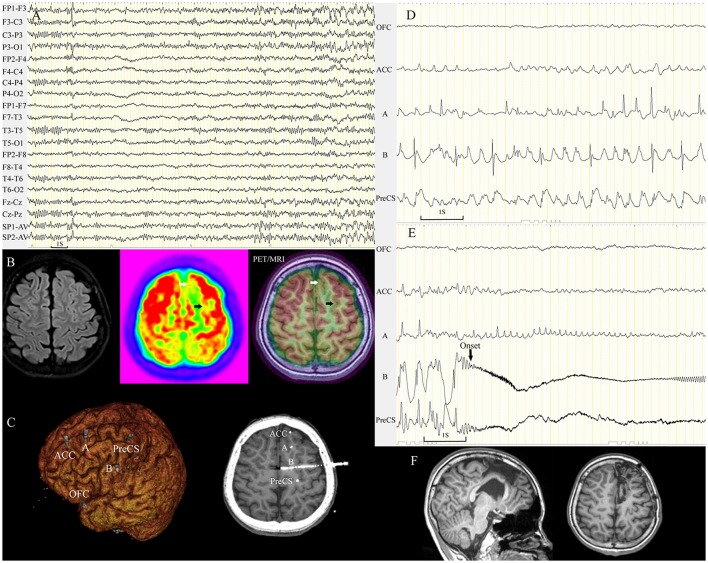
Subtle hypometabolic change tended to be overlooked by conventional visual analysis. A 12-year-old boy (patient 32) with nocturnal seizures manifesting as aura (fear/fluster), tachycardia, fearful expression, dystonic posturing of the right limbs, and hypermotor activity. Ictal scalp EEG demonstrated sharp waves in the left frontal lobe (A). Visual analysis identified focal PET hypometabolism in the left mesial frontal region (white arrow). PET/MRI detected a very subtle hypometabolic change (black arrow) in the ipsilateral superior frontal sulcus (B). Five electrodes were implanted in the left frontal area including the two hypometabolic sulci (C). Asynchronous spikes arose from the two sulci during the interictal period (D), and seizures (14 onsets during SEEG monitoring) originated from the left superior frontal sulcus (E). The two sulci were removed, and both were FCD IIB (F). The patient remained seizure-free through the last follow-up at 18 months. ACC, anterior cingulate cortex; OFC, orbitofrontal cortex; PreCS, precentral sulcus.